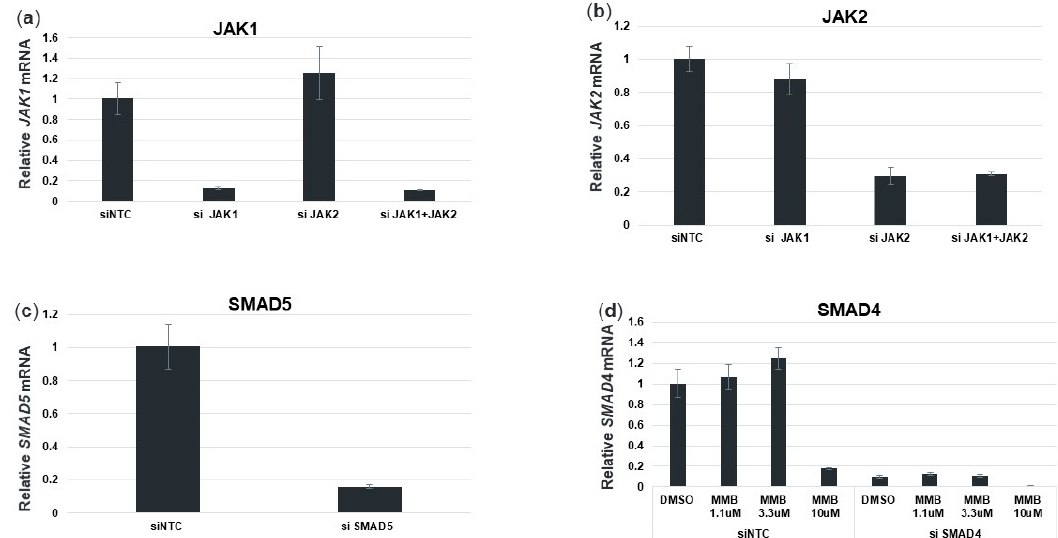
Figure A2. The siRNA-mediated knockdown of signaling pathway components. Pooled siRNA against JAK1 and / or JAK2 ( a , b ) or SMAD5 ( c ) or non-targeting control (siNTC) was used to deplete these targets in human primary hepatocytes. The qPCR analysis for the respective targets showed over 70% mRNA reduction for all. ( d ) After siRNA treatment with siNTC or siSMAD4, hepatocytes were treated with DMSO or momelotinib for 18 h prior to mRNA analysis. SMAD4 knockdown was greater than 80%. Each experiment was conducted in triplicate and average and SD are